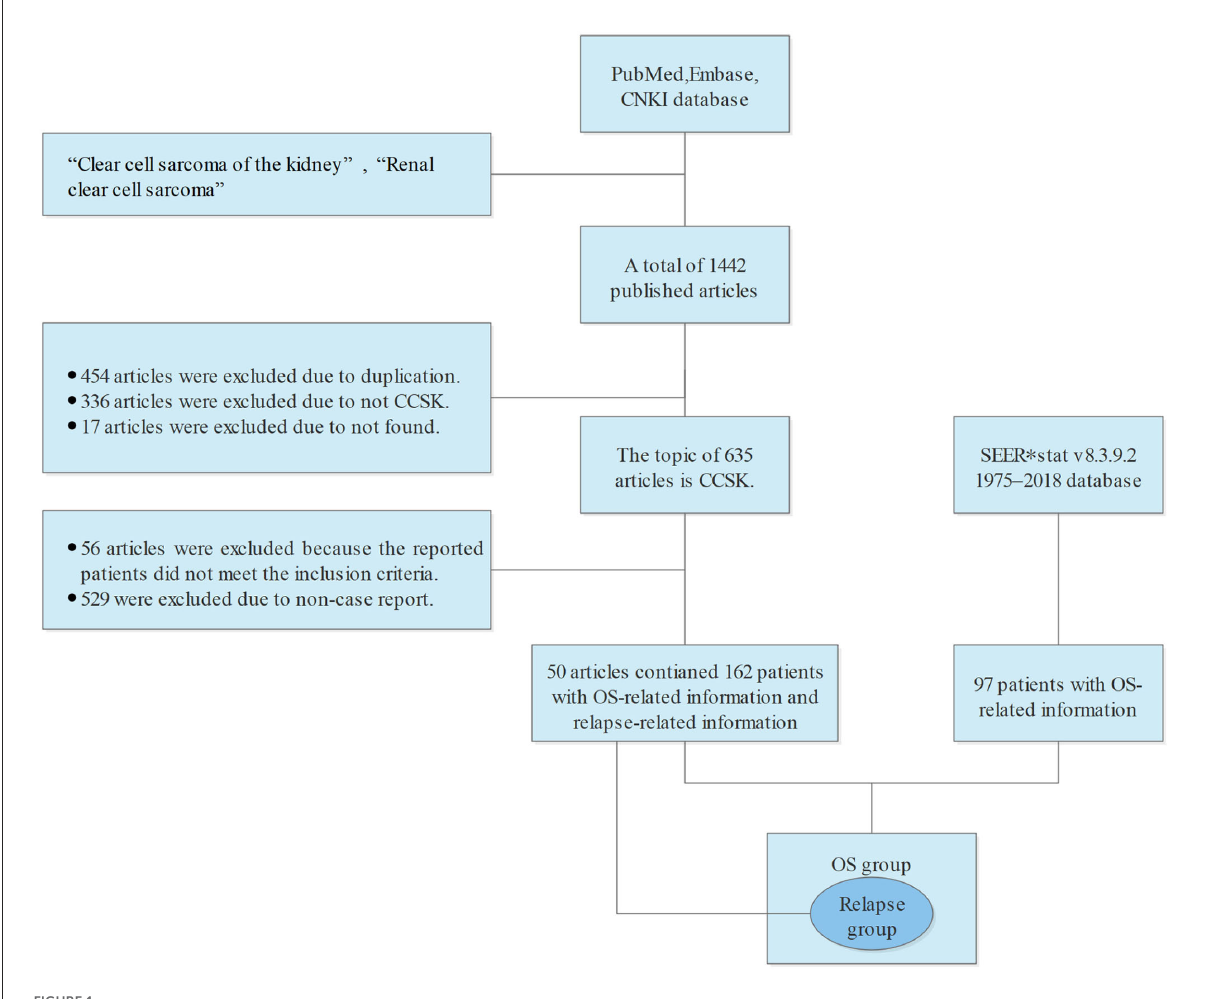
FIGURE1 Flow chart of obtaining data and filtering